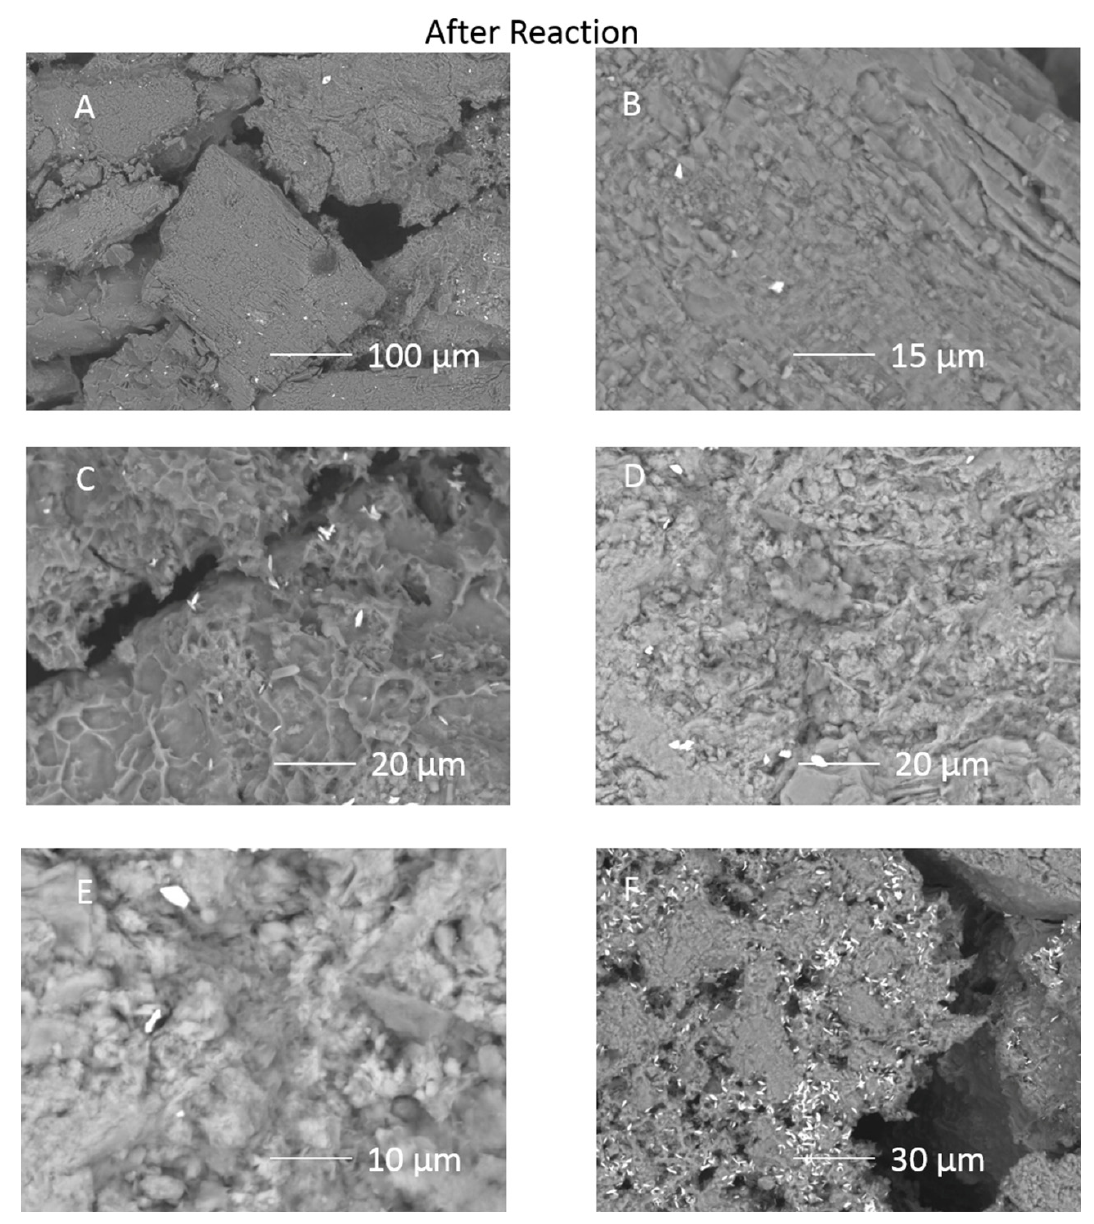
Figure 4. SEM images of the inner surface of the cap ‐ rock sub ‐ sample after reaction ( A ) surface view of Ca ‐ Na ‐ plagioclase (andesine) grain with surrounding calcite cement dissolved; ( B ) Ca ‐ Na ‐ plagioclase surface; ( C ) smectite precipitate layer; ( D ) corroded chlorite surface with precipitated material in the center; ( E ) corroded chlorite surface and bright barite crystal; ( F ) pore filling clay revealed by calcite dissolution, and bright barite precipitates.